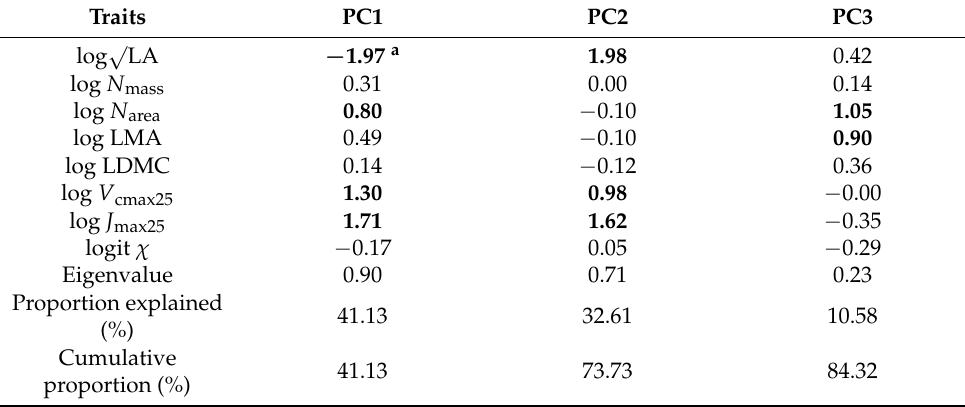
Table 2. Trait loading, eigenvalues and percentage of trait variation explained by the first three principal components (PCs). LA: leaf area; N mass : leaf nitrogen content; N area : leaf nitrogen per area; LMA: leaf mass per area; LDMC: leaf dry mass content; V cmax25 : maximum carboxylation rate standardized to 25 ◦ C; J max25 : maximum electron transport rate standardized to 25 ◦ C; χ : ratio